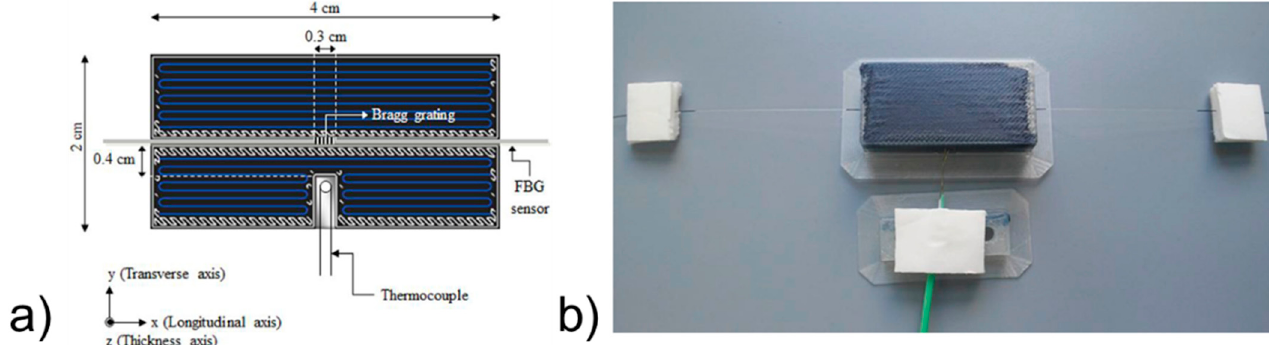
Figure 8. ( a ) Schematic of the midplane of a 0 ◦ fiber reinforcement orientation of a 3D printed CFRTPC with the location of the FBG sensor and the thermocouple, and ( b ) picture of a 3D printed CFRTPC specimen containing an embedded FBG sensor and a thermocouple [71] (copyright (2019), with permission from Elsevier).